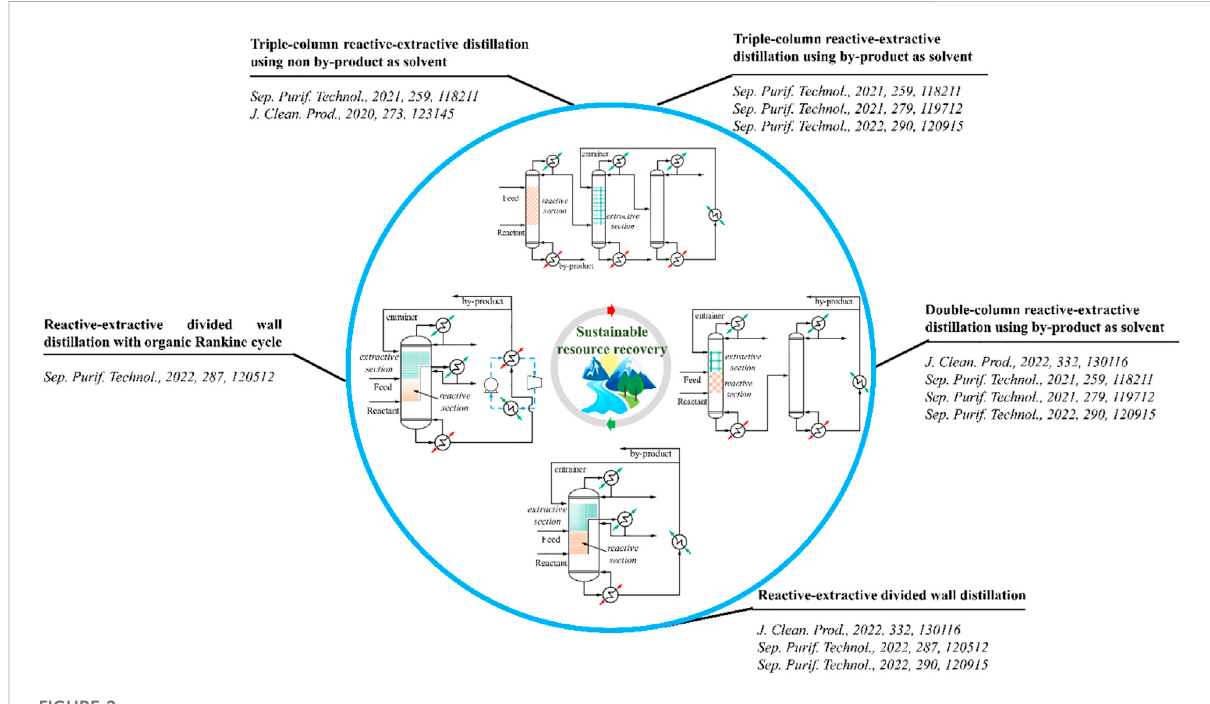
Summary of existing studies on RED for the separation of ternary azeotropic